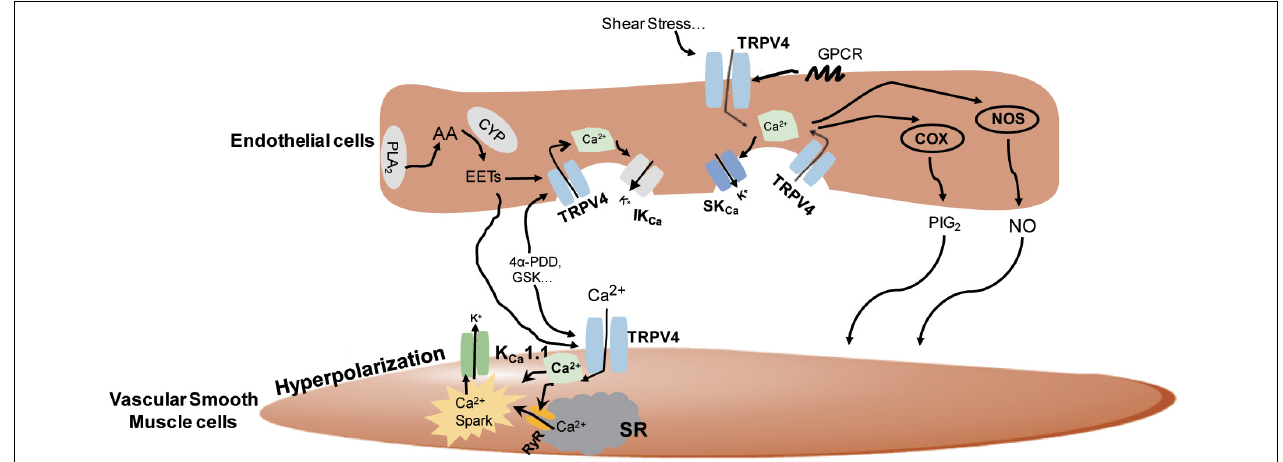
FIGURE 2 | The underlying mechanisms of the regulation of TRPV4 in vasodilation. In the vascular endothelial cells, TRPV4 can be activated by stimuli-sensing, G protein-coupled receptors (GPCR) activation, epoxyeicosatrienoic acid (EETs), GSK1016790A (GSK), and 4 α -PDD. Its activation leads to Ca 2 + influx and the subsequent activation of nitric oxide synthase (NOS), cyclooxygenase (COX), and intermediate-conductance Ca 2 + -sensitive K + channels/small conductance Ca 2 + -sensitive K + channels (IK Ca /SK Ca ) channels to induce nitric oxide (NO), prostacyclin (PGI 2 ), and endothelial-derived hyperpolarizing factor (EDHF) production, respectively, and causes vasodilation. In smooth muscles, TRPV4 can be activated by endothelial-derived EETs or chemical agonists, leading to Ca 2 + entry-induced Ca 2 + release from ryanodine receptor (RyR) in the sarcoplasmic reticulum (SR), the stimulation of Ca 2 + sparks, and the subsequent activation of K Ca 1.1 to stimulate smooth muscle hyperpolarization and